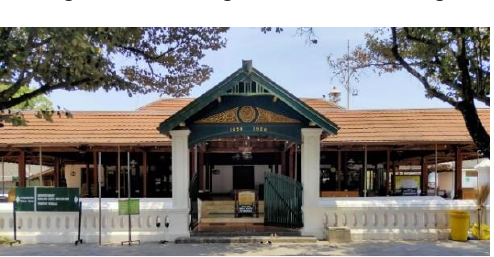
Figure 4. Kotagede Great Mosque Building